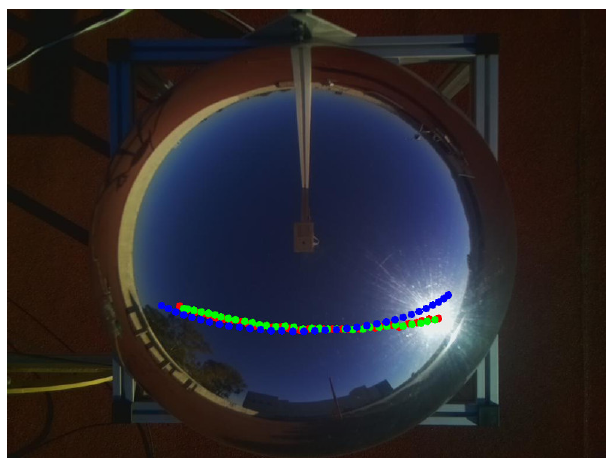
Figure 22. Trajectory of the Sun given by the segmentation process (red dots), the particle filter (green dots), and the estimated position (blue dots), during the day.